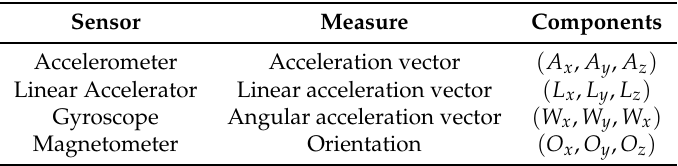
Table 1. Description of components of raw